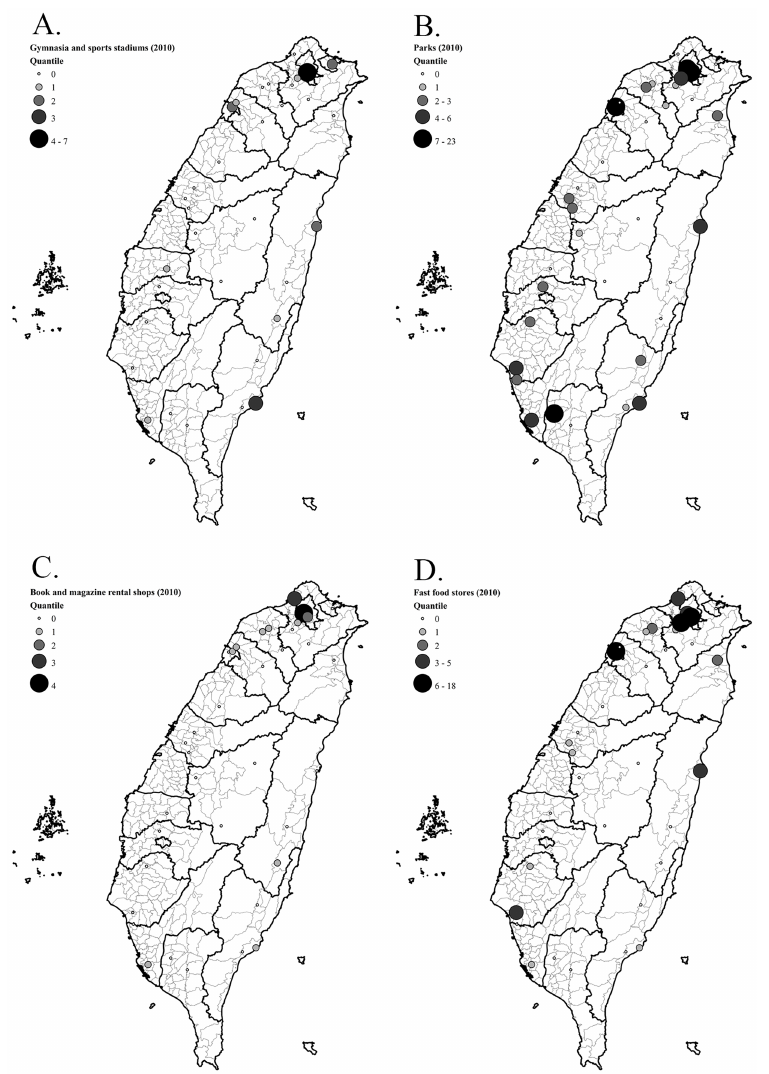
Fig 1. The number of facilities within 1000m around each Taiwanese junior high school in NAHSIT (2010). (A) gymnasiaand sports stadiums; (B) parks; (C) book and magazinerental shops; (D) fast food